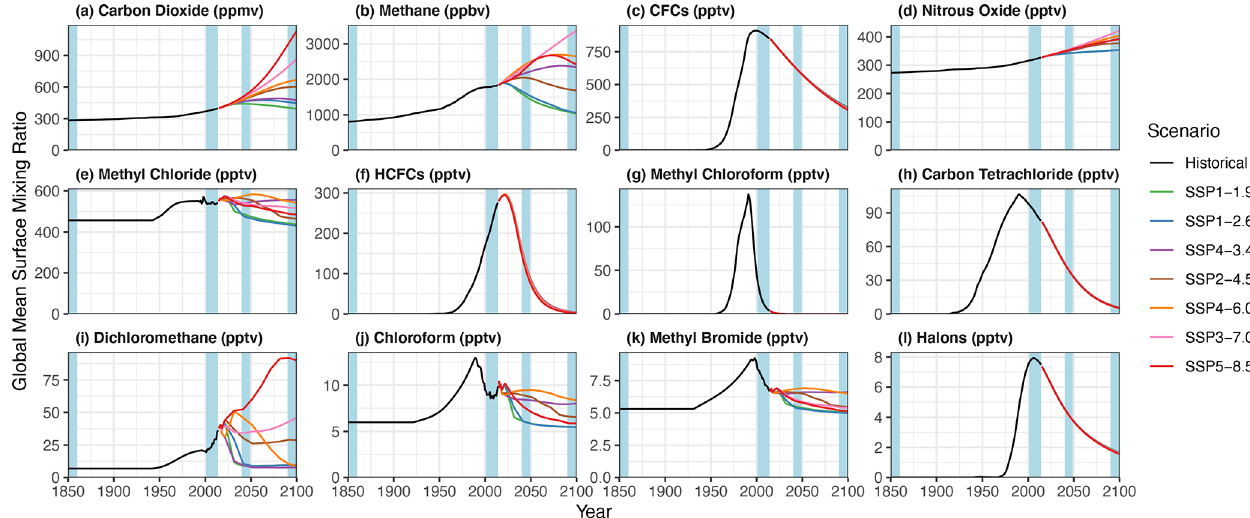
Figure 7. Time series of annual mean CMIP6 surface boundary conditions for 1850–2100CE. Individual panels show the temporal evo- lution of (a) carbon dioxide (CO 2 ) in ppmv ( ≡ µmolmol − 1 ), (b) methane (CH 4 ) in ppbv ( ≡ nmol mol − 1 ), (c) total chlorofluorocarbons (CFCs ≡ CFC11 + CFC12 + CFC113 + CFC114 + CFC115) in pptv ( ≡ pmolmol − 1 ), (d) nitrous oxide (N 2 O) in pptv, (e) methyl chlo- ride (CH 3 Cl) in pptv, (f) total hydrochlorofluorocarbons (HCFCs ≡ HCFC141b + HCFC142b + HCFC22) in pptv, (g) methyl chloroform (CH 3 CCl 3 ) in pptv, (h) carbon tetrachloride (CCl 4 ) in pptv, (i) dichloromethane (CH 2 Cl 2 ) in pptv, (j) chloroform (CHCl 3 ) in pptv, (k) methyl bromide (CH 3 Br) in pptv, and (l) total halons ( ≡ Halon1211 + Halon1301 + Halon2402) in pptv. Historical boundary conditions are from Meinshausen et al. (2017) and future boundary conditions are described by Riahi et al. (2017). The shaded blue rectangles indicate periods for which GCAP 2.0 input meteorology is available at the time of